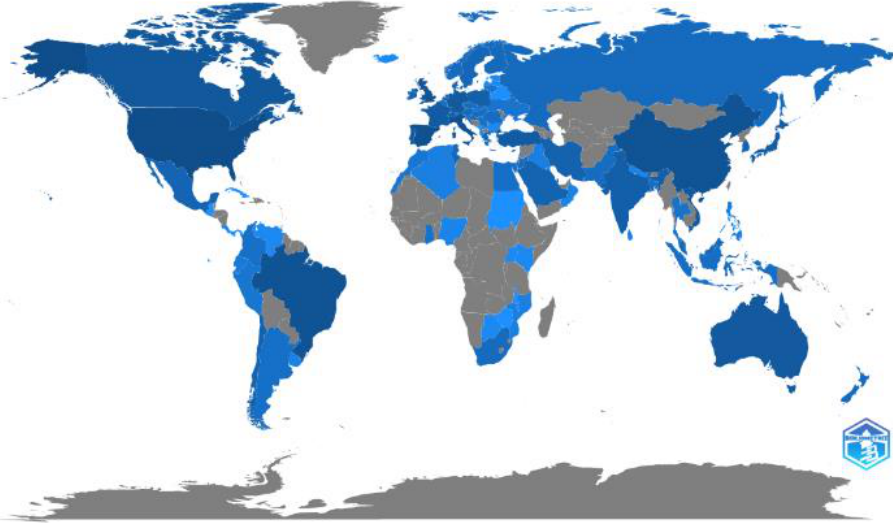
Figure 2. Physical activity and coronavirus disease studies (2020–2021) by country. The intensity of blue represents the publication level. Table 4. Top 10 countries with the highest level of scientific production in physical activity and coronavirus disease (2020 – 2021).